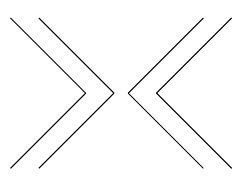
Figure 17. Structure of a double trace